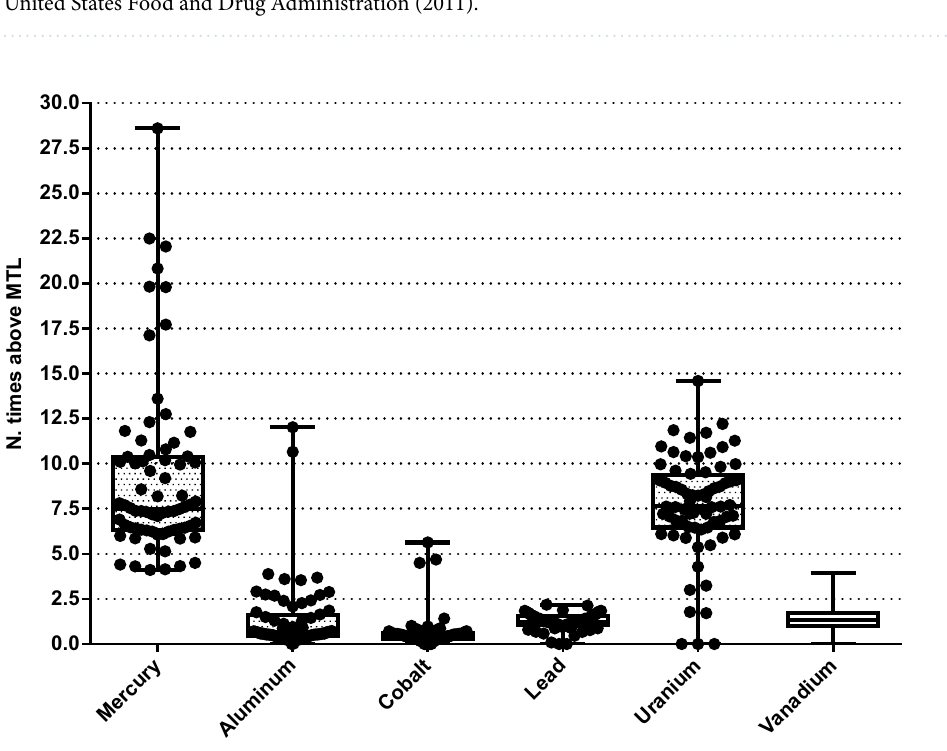
Figure 1. Number of times above the maximum tolerated level (MTL) for toxic metals that had values above that limit, in commercial dog